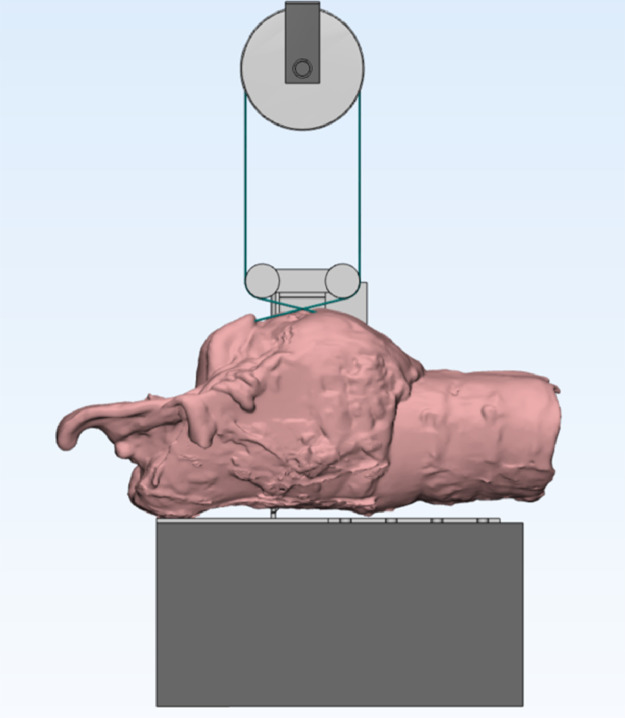
Experimental set-up.